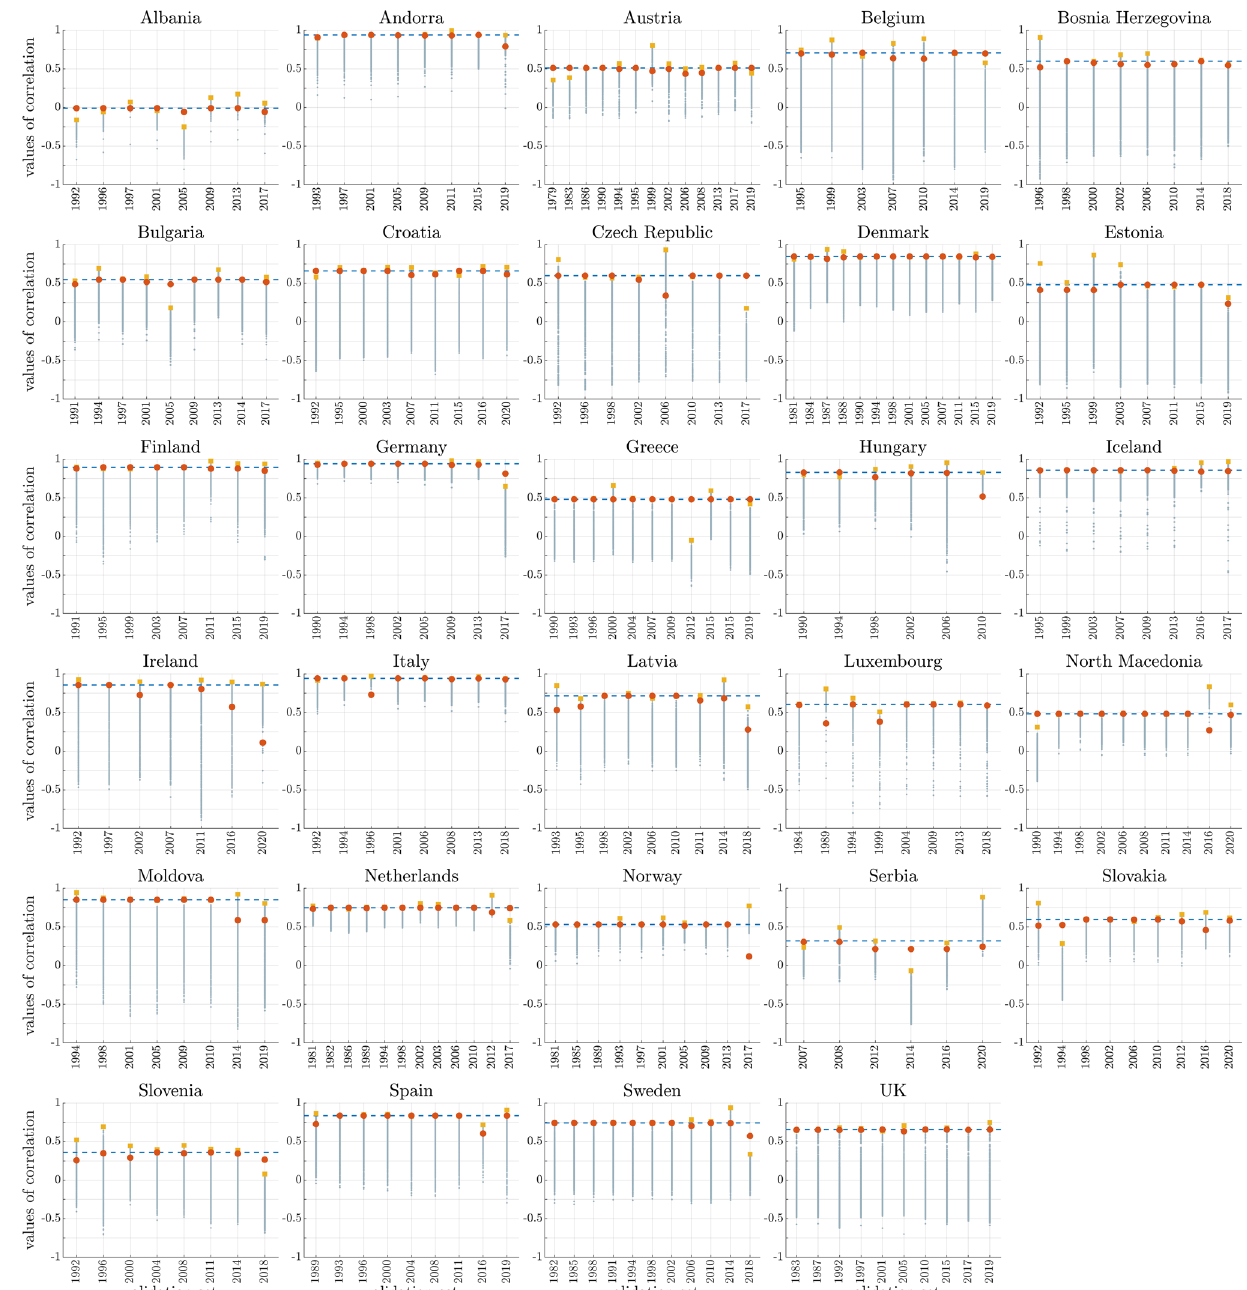
Figure 4. Leave-one-out analysis of the correlation for scenario III . A single election is used for the validation set, and the remaining elections (training set) are used to calculate the correlation (frustration v.s. duration of the government negotiation talks) for each choice of political positions in the left-right grid. 1000 sets of values for the left-right political positions of the parties were randomly selected on the preassigned left-right grid. Here the corresponding correlation values for each set are shown (gray dots), together with the overall country maximum value (yellow square) corresponding to the optimal choice for the weights. Red circles represent the values of correlation obtained when the excluded election is considered (the frustration is calculated using the optimal choice for the weights found using the training set). A blue dashed line represents the value of correlation obtained if the weights are tuned so as to maximize the correlation when all the elections are considered (i.e., scenario III ). The red circles are normally very close to the yellow squares, meaning that the leave-one-out test is normally